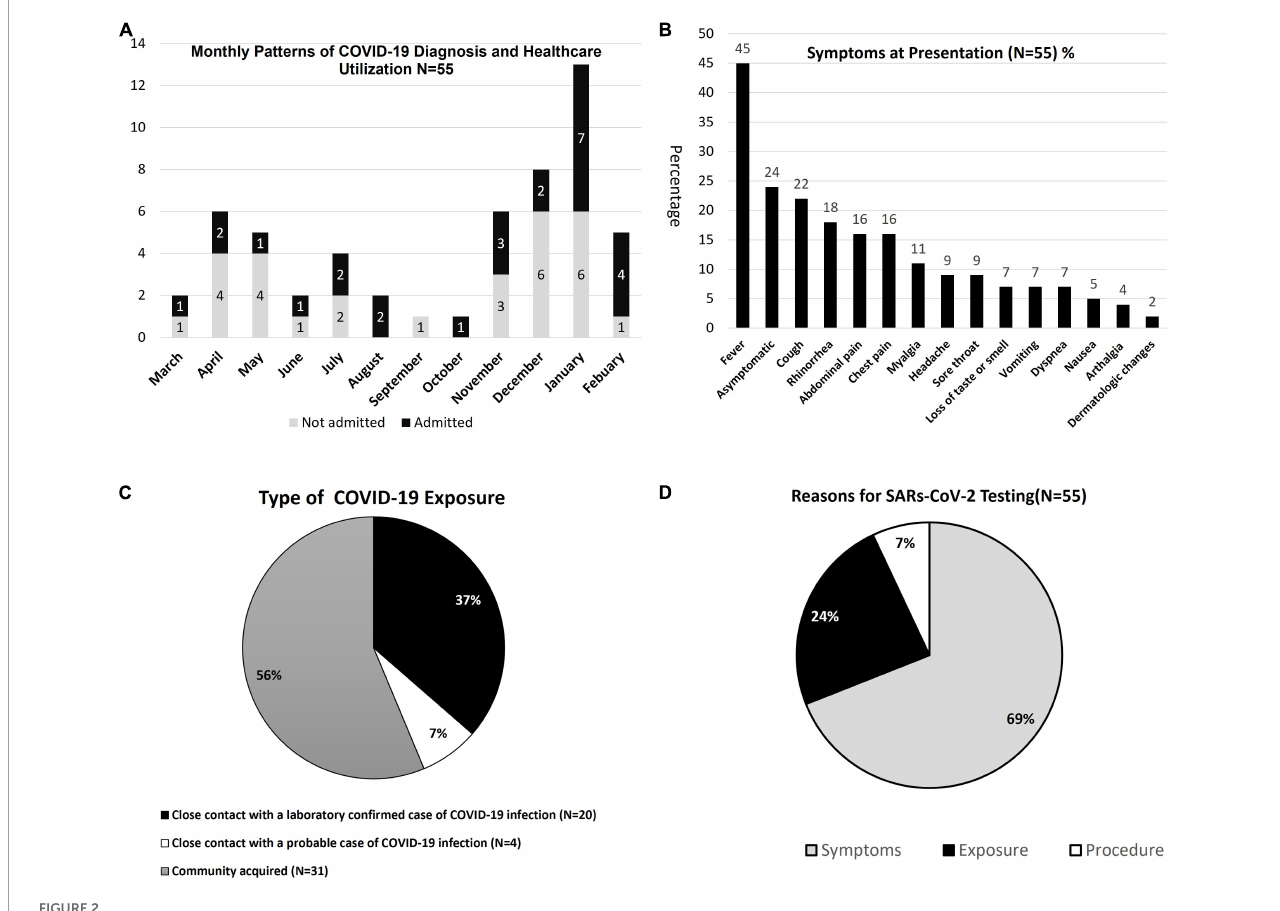
FIGURE2 (A–D) COVID-19 admission patterns, symptoms, exposures, and testing.